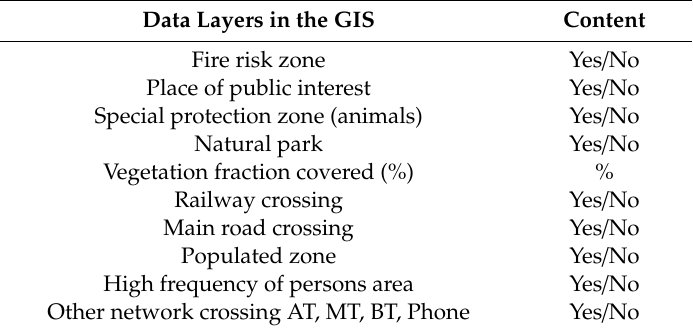
Table 4. Data in the GIS layers to be assigned to a functional